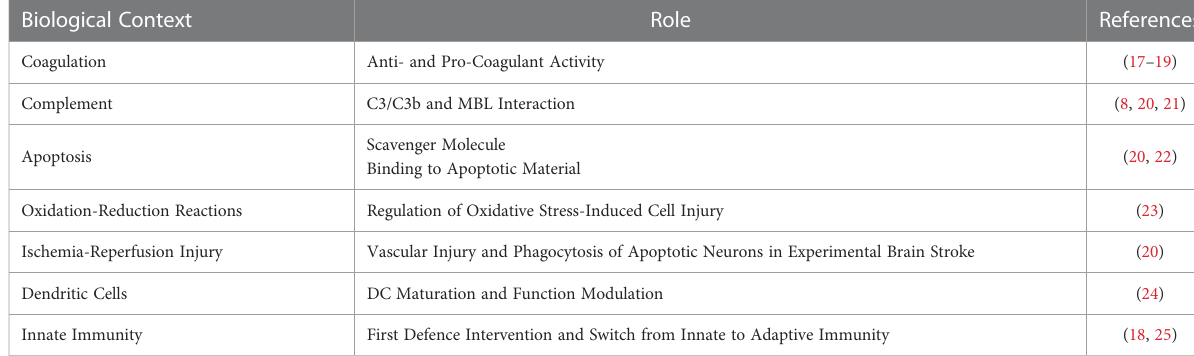
TABLE 1 b 2GPI pleiotropic